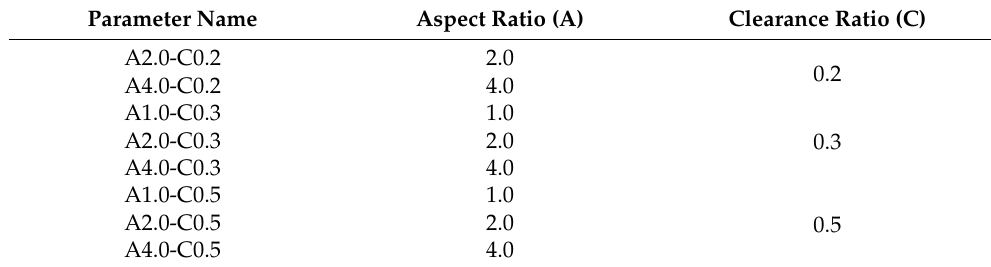
Table 3. CFD analysis parameters.